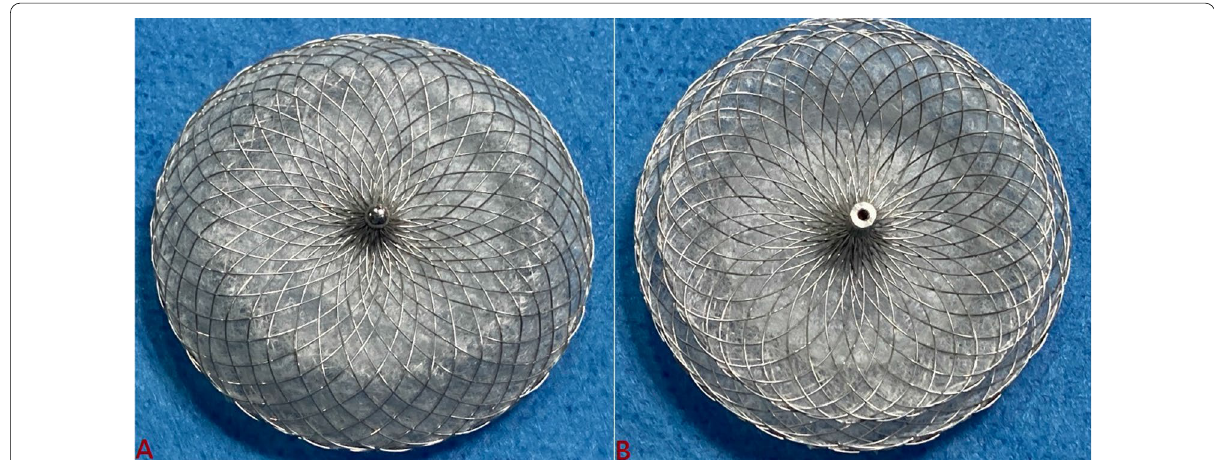
Fig. 1 Cocoon septal occluder is a self-expandable, dual-disk structure which is composed of platinum-coated nitinol wire. A Left atrial disk; B right atrial disk